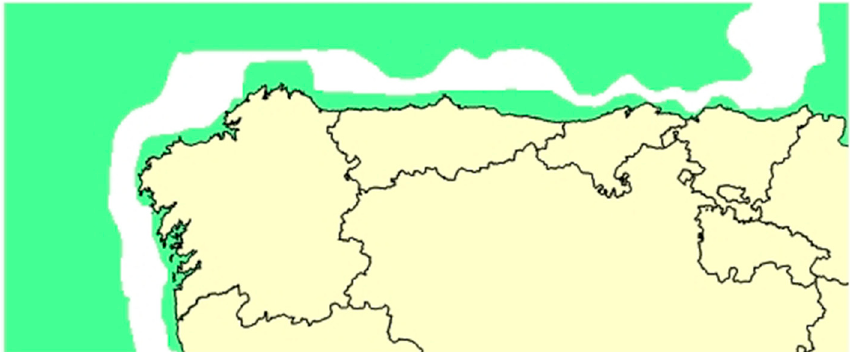
Figure 7. Bathymetry restriction for the semisubmersible platform.